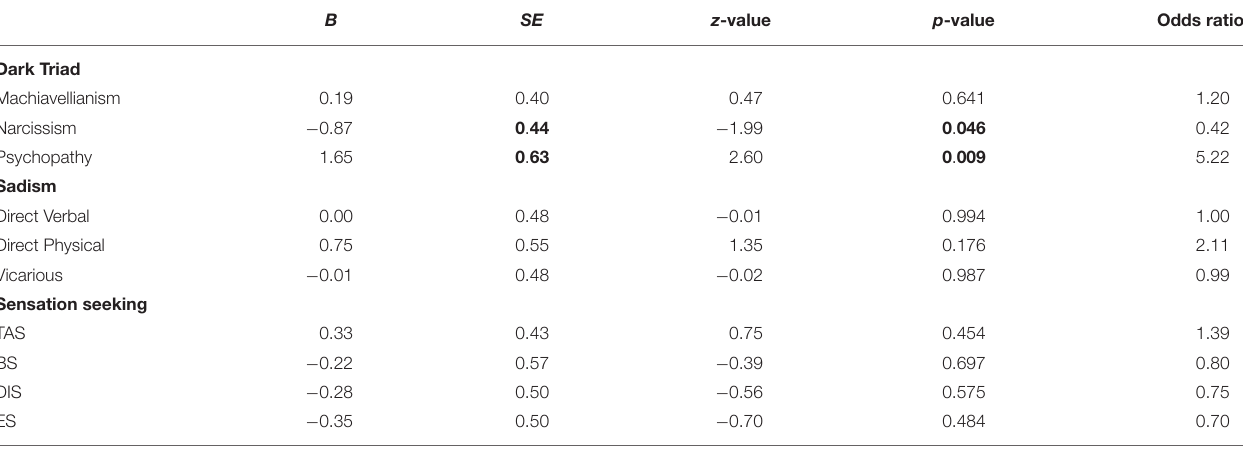
TABLE 3 | Logistic regression with fire setting as criterion